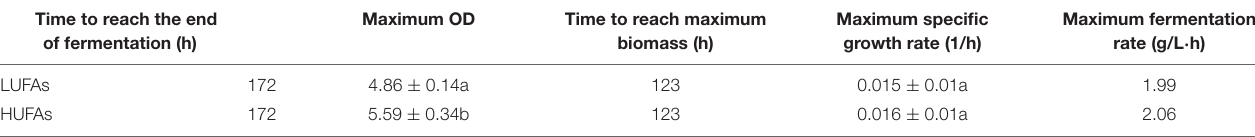
TABLE 1 | Important parameters of yeast fermentation in MS300 media supplemented with high (HUFA) or low (LUFA) concentrations of UFAs.